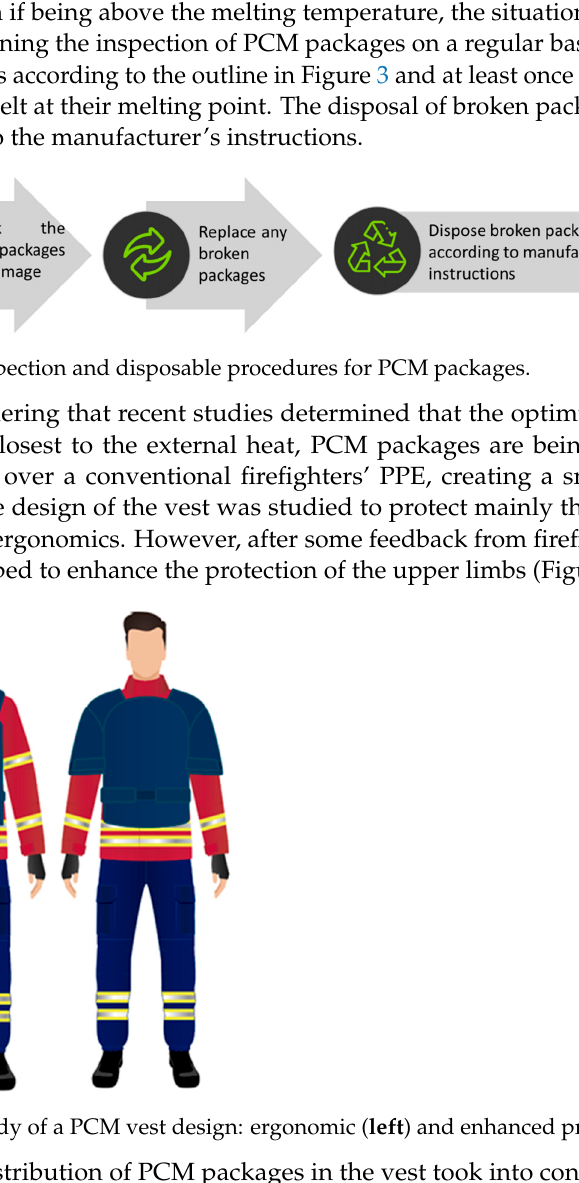
Figure 5. Study of the integration of PCM packages in the vest.